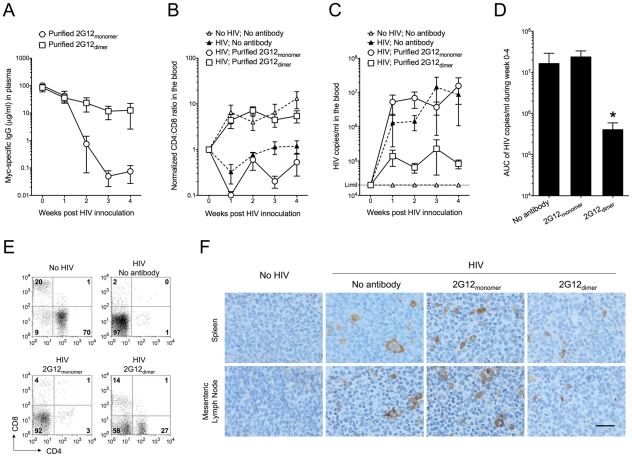
Protection against HIV-1 infection in humanized mice by passively transferred 2G12 dimer.Humanized mice were injected (i.v.) with 0.5 mg of purified 2G12 monomer (n = 6) or 2G12 dimer (n = 5) at 4 months of age and challenged by HIV-1JR-CSF (i.v.; 400 ng of p24) one day after passive transfer. (A) Concentrations of 2G12 in the mouse plasma. 2G12 was measured by Myc-specific ELISA and data are shown as average ± s.e.m. All data shown from now on are average ± s.e.m. unless a bar graph is shown, where the data are presented as average + s.e.m. (B) The ratios of human CD4:CD8 in the peripheral blood. CD4 and CD8 cell populations were measured weekly by flow cytometry. The ratios of CD4:CD8, after normalization to week-0 values (set as 1), were plotted. Mice with no antibody but HIV-1 challenge (n = 7) and mice with neither antibody nor HIV-1 (n = 6) were used as controls. The CD4:CD8 ratio in this humanized mouse model increased with the age of the mice as seen in the “No HIV; No antibody” control. Therefore, all mice involved in this study were age-matched. One-way analysis of variance (ANOVA) with Tukey's multiple comparison posttest showed that the group with 2G12 dimer was not different from the No HIV-1 control (p>0.05); however, it had significantly higher CD4:CD8 ratios than the group with 2G12 monomer (p<0.05). All data points in each treatment group, regardless of time, were included in the ANOVA. (C) Viral load in the mouse plasma. Viral RNA was extracted from mouse plasma and the viral load was measured. The detection limit of the assay was 20,000 HIV-1 copies/ml of mouse plasma. The differences were not statistically significant. (D) Total viral load from week 0 to week 4. Area under the curve (AUC) of the viral load during week 0-4 was calculated and plotted. The group with 2G12 dimer had significantly lower viral load than the other two groups based on individual Mann-Whitney tests (p = 0.0303 between 2G12 dimer and No antibody; p = 0.0159 between the 2G12 dimer and 2G12 monomer). (E) Percentages of human CD4 and CD8 T cells in the spleen after 4 weeks. Plots shown were pre-gated on CD3 T cells. (F) Immunohistochemical analysis of HIV-1 p24 in the spleen and mesenteric lymph node after 4 weeks. The images were taken using an Olympus BX51 microscope with 400× magnification (Scale bar, 25 µm).